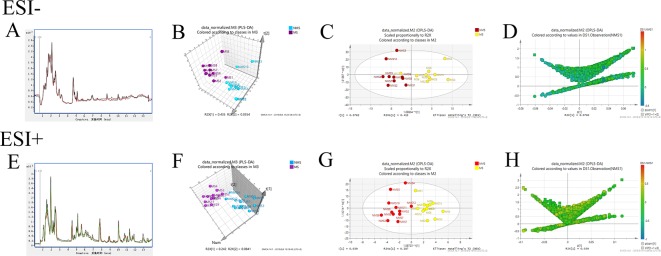
Model analysis of nontargeted metabolomics of brain tissues in SD rats. (A) TIC mass spectrum in negative ion mode. (B) PLS-DA 3D score plot in negative ion mode of the NMS and MS groups. (C) OPLS-DA score plot in negative ion mode of the NMS and MS groups. (D) The corresponding OPLS (V+S) plot of the NMS and MS groups in negative ion mode. (E) TIC mass spectrum in positive-ion mode. (F) PLS-DA 3D score plot in positive-ion mode of the NMS and MS groups. (G) OPLS-DA score plot in positive-ion mode of the NMS and MS groups. (H) The corresponding OPLS (V+S) plot of the NMS and MS groups in positive-ion mode.